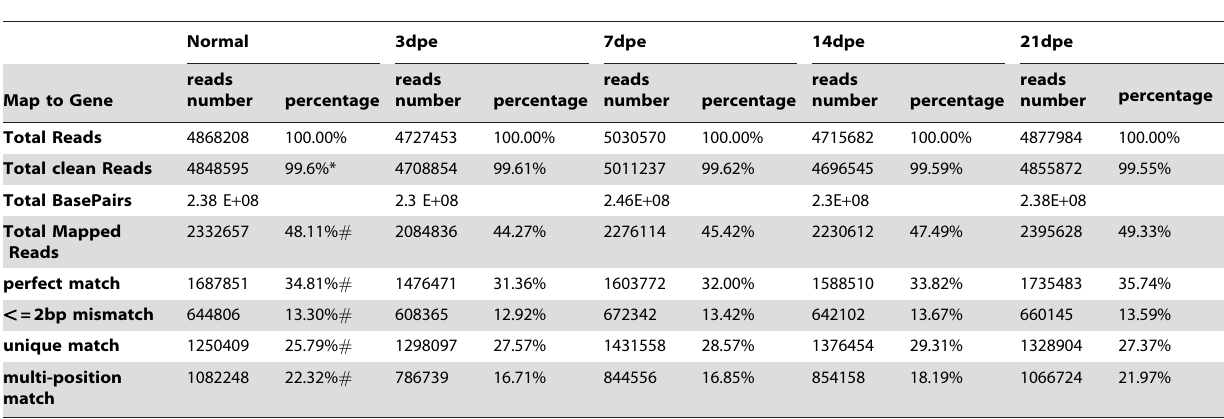
Table 1. Summary alignment statistics in Normal, 3dpe, 7dpe, 14dpe and 21dpe libraries.